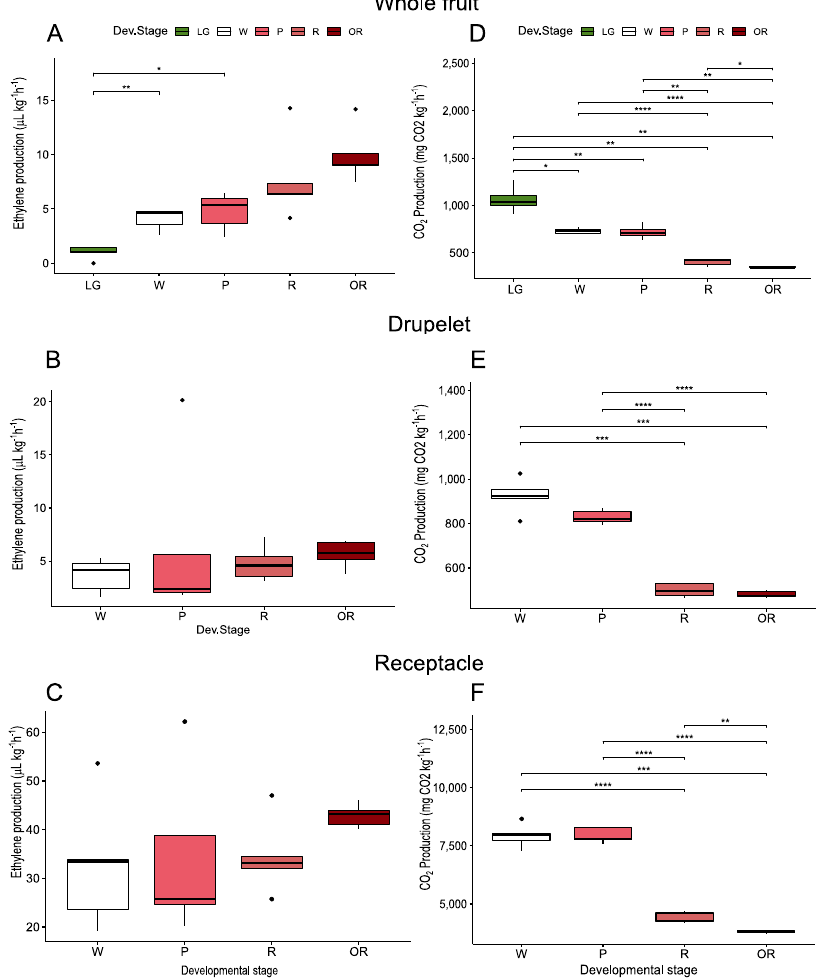
Figure 2. Physiological parameters during the development of raspberry ( Rubus idaeus ‘Heritage’) fruit. The fruit was harvested and sorted by size and color as follows: large green (LG), white (W), pink (P), red (R) and overripe (OR) fruit. Ethylene production ( µ L kg − 1 h − 1 ) and CO 2 production (mg CO 2 kg − 1 h − 1 ) were determined in whole fruit ( A , D ), drupelets ( B , E ) and receptacles ( C , F ) from each stage. The drupelets and the receptacle of the green stage cannot be separated, and the CO 2 and ethylene production were non-determined (n.d) in the drupelets and receptacle. Data represent the means ± S.D. from five sample units (each containing ten fruits) by the development stage. Asterisks indicate significant differences between all developmental stages, p ≤ 0.05 (*), p ≤ 0.01 (**), p ≤ 0.001 (***) and p ≤ 0.0001 (****). Boxplots show each group’s distribution (developmental stages), and the black line (central value in the box) signs the median value. Points out of the boxplots show outlier